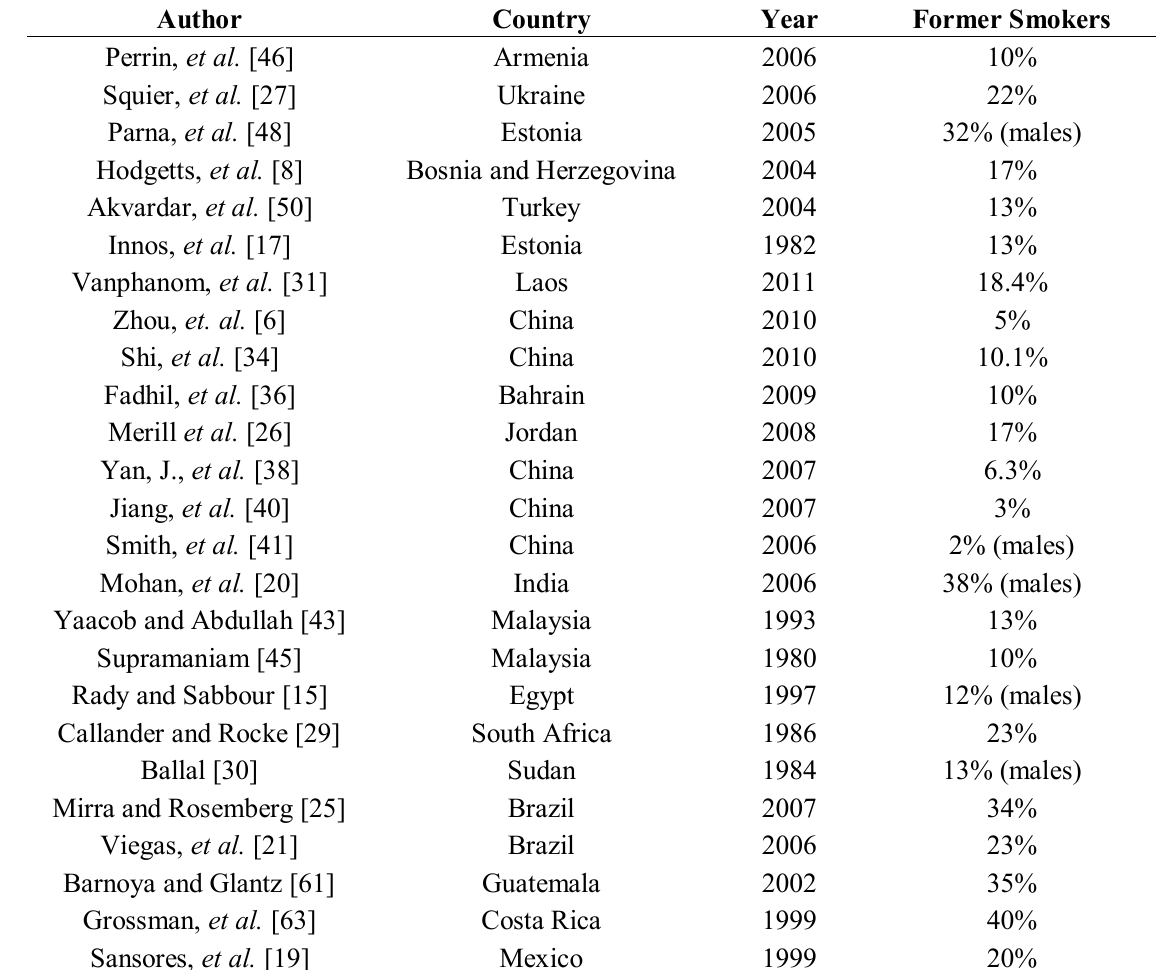
Table 2. Former smoking rates among physicians as reported by 25